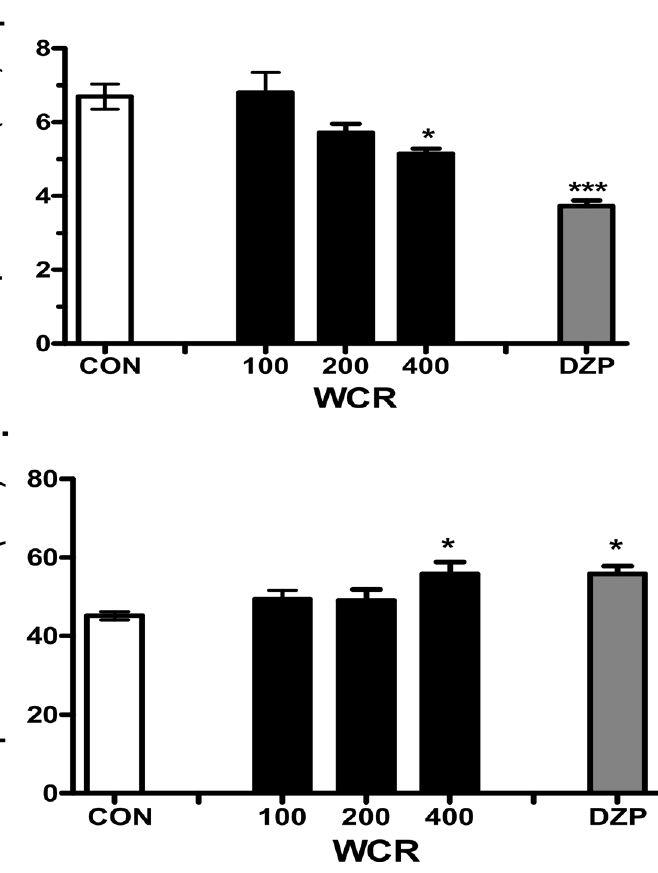
Figure 4. Effects of WCR on the onset time of sleep ( A ) and sleep duration time ( B ) in mice induced with sedative–hypnotic pentobarbital (30 mg/kg). Each column displays the mean ± SEM. Statistical analysis was conducted using one-way ANOVA followed by Tukey’s test. * p < 0.05, *** p < 0.001, significantly different compared with the CON group. Mice were injected with pentobarbital 30 min after treatment with WCR or DZP (Diazepam). The CON group: treatment with vehicle and pen- tobarbital sodium (30 mg/kg); the WCR groups: treatment with WCR (100 or 200 or 400 mg/kg) and pentobarbital sodium (30 mg/kg); the DZP group: treatment with diazepam 2 mg/kg and pentobarbital sodium (30